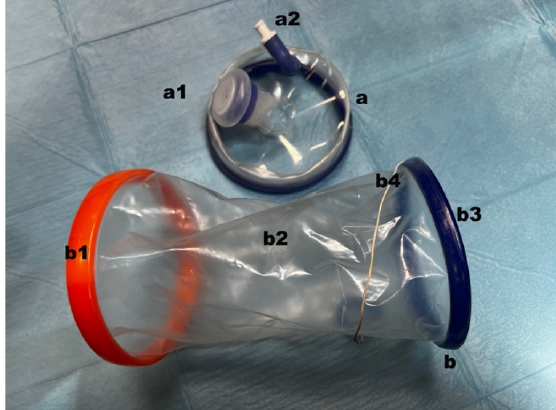
Figure 1. Images of wound retractor laparoscopic platform employed: ( a ) cap; ( a1 ) instrumental port; ( a2 ) CO 2 inlet plug; ( b ) retractor; ( b1 ) outer ring; ( b2 ) polyurethan cylindrical sleeve; ( b3 ) inner ring; ( b4 ) removal tag.